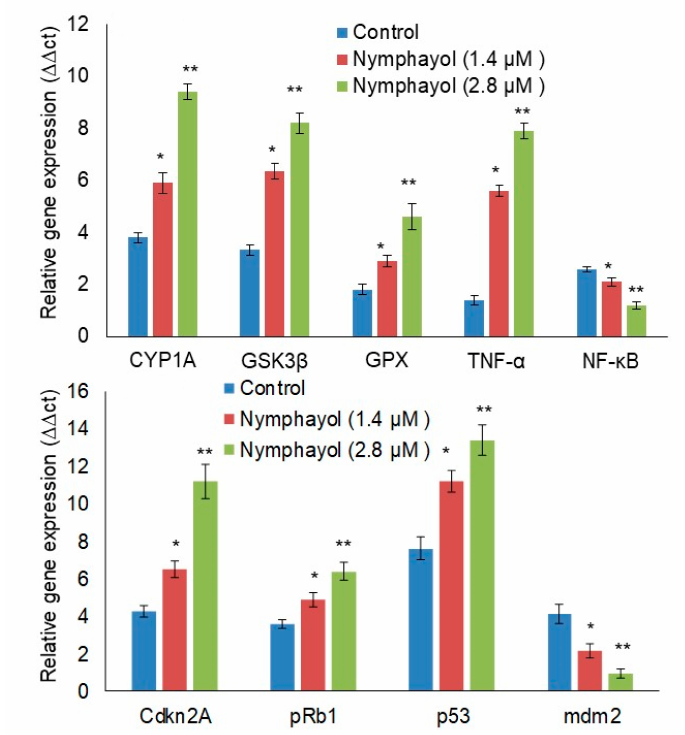
Figure 5. E ff ect of nymphayol on the expression levels of proapoptotic and tumor suppression related mRNA levels in MCF-7 cells after 48 h. Data are presented as the means ± SD (n = 6). Values sharing a common superscript as ** p ≤ 0.001 compared with 1.4 µ M of nymphayol and vehicle control; * p ≤ 0.01 compared with the vehicle